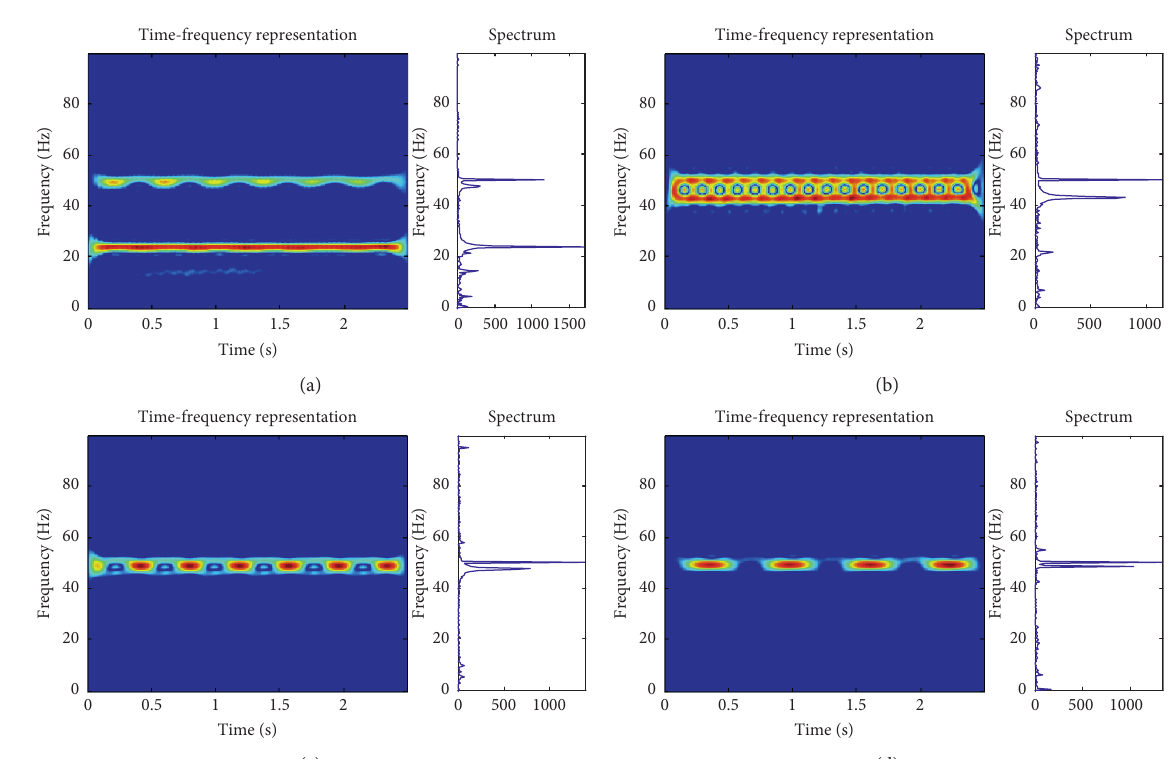
Figure 7: Time-frequency distribution of the tension test signal of static ropes under different excitation